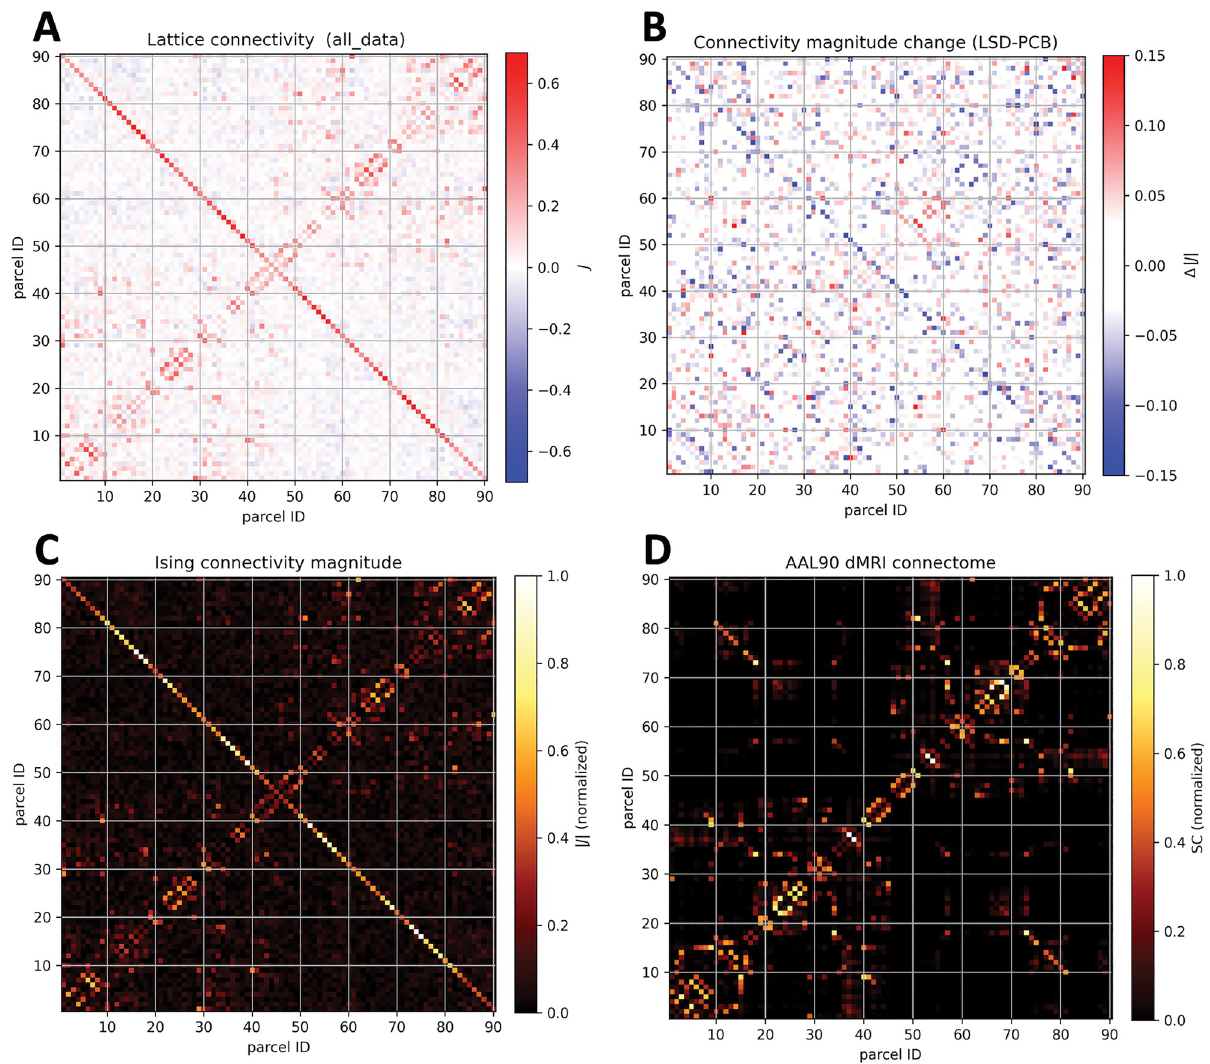
Fig 1. Archetype connectivity. A) Global archetype (combining all data) Ising connectivity. The down-trending diagonal values reflect strong inter- hemispheric homotopic connectivity. B) Difference in connectivity magnitude between the placebo and LSD archetypes, with a visible loss in homotopic connectivity (see also figures in section 5, S1 Text). C) Unsigned global archetype Ising connectivity. D) AAL